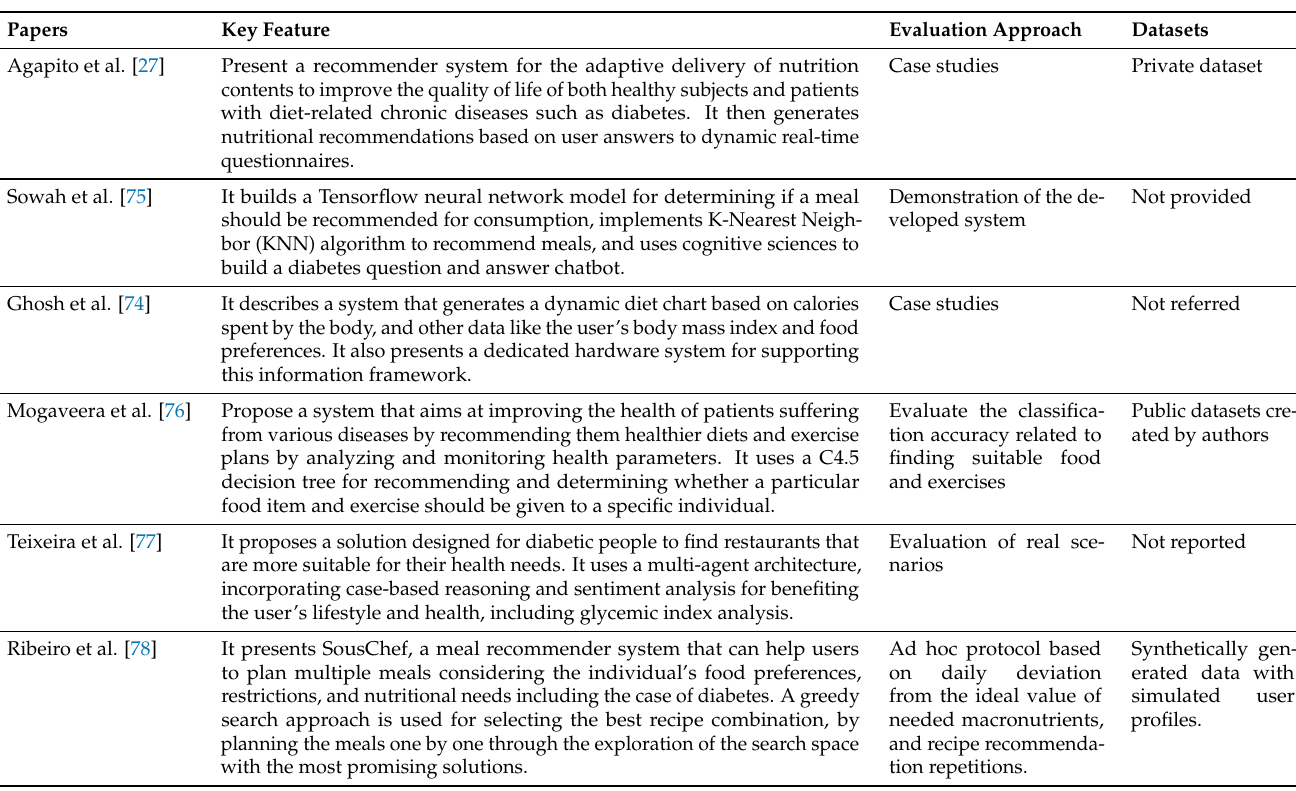
Table 4. Summary of the identified related works using interaction-based